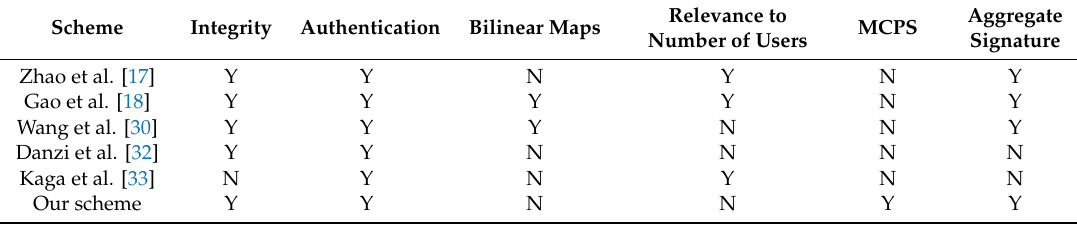
Table 2. The comparison of relevant blockchain-based